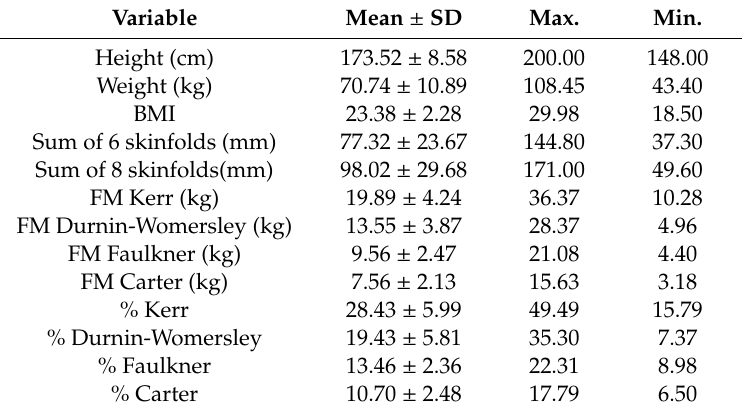
Table 1. Descriptive analysis of kinanthropometry variables and fat masses and percentages. Variable Mean ± SD Max.